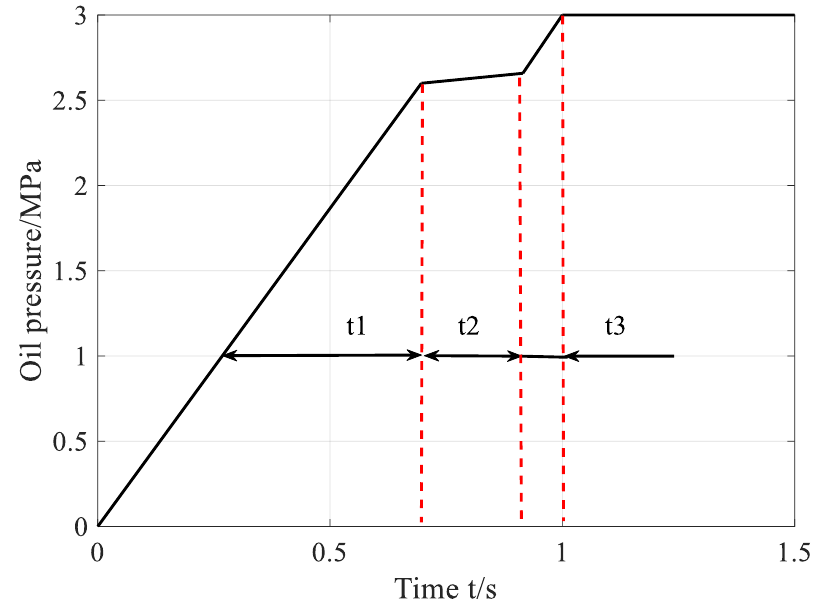
Figure 13. Optimal oil filling control strategy for verification conditions.